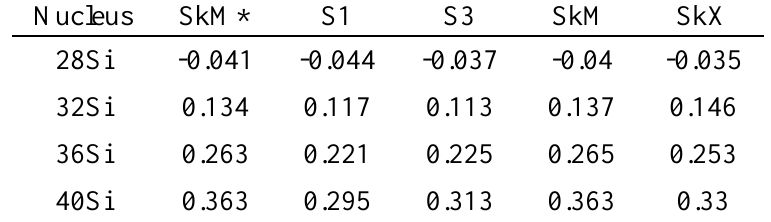
Fig. 9: The neutron skin of Si-isotopes, calculated by different Skyrme parameterizations. Table 4: The skin thickness of the selected isotopes calculated by different Skyrme